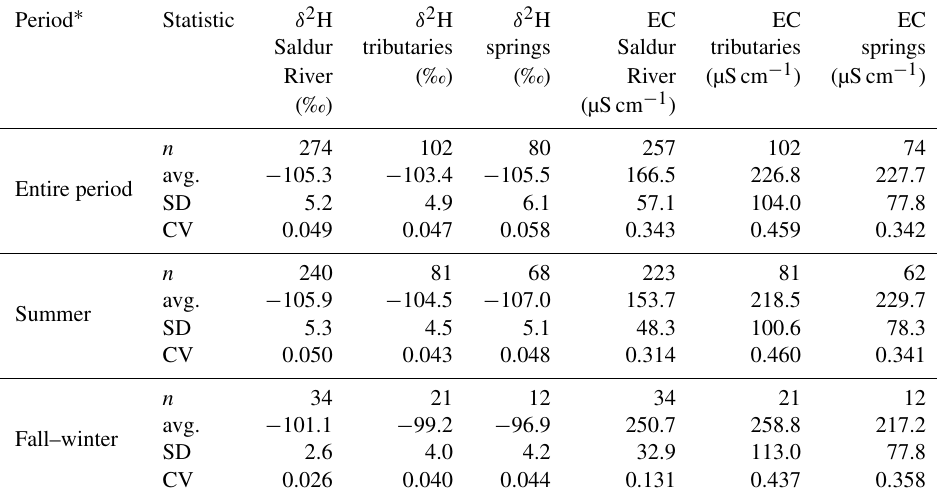
Table 6. Basic statistics of isotopic composition ( 2 H) and EC of stream water in the Saldur catchment for data collected in the three sampling years. CV: coefficient of variation. The other abbreviations are used as in Table 2. Note that for simplicity the negative sign from the coefficient of variation of isotope data was removed. Period ∗ Statistic δ 2